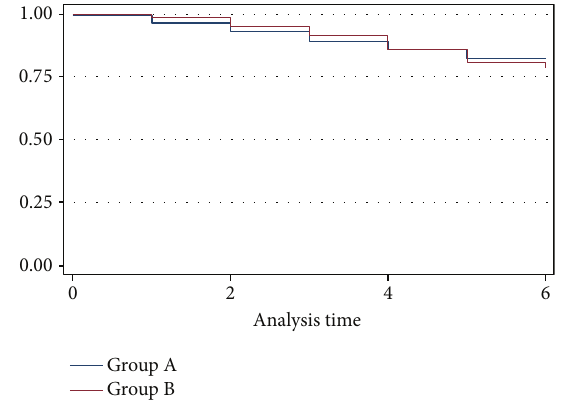
Figure 4: KM estimates wound healing